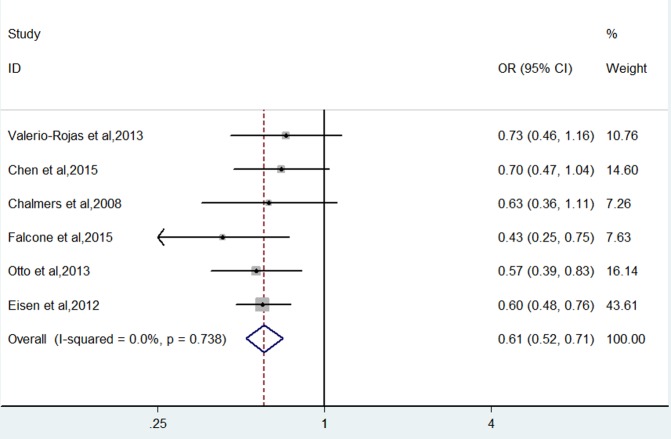
Forest plot showing the effect of anti-platelet therapy on mortality.